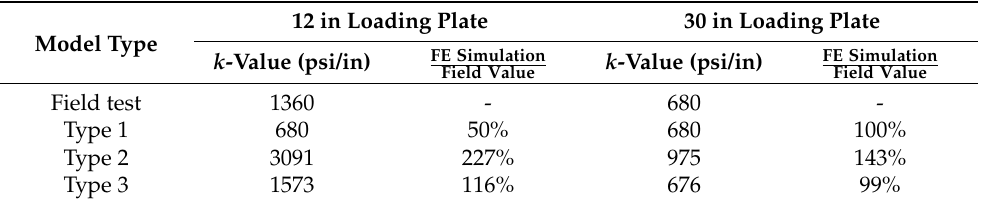
Table 4. Computed k -values on top surface of the AC stabilized layer by finite element (FE) simulation (1 in = 25.4 mm, 1 psi/in = 271 kN/m 3 ).